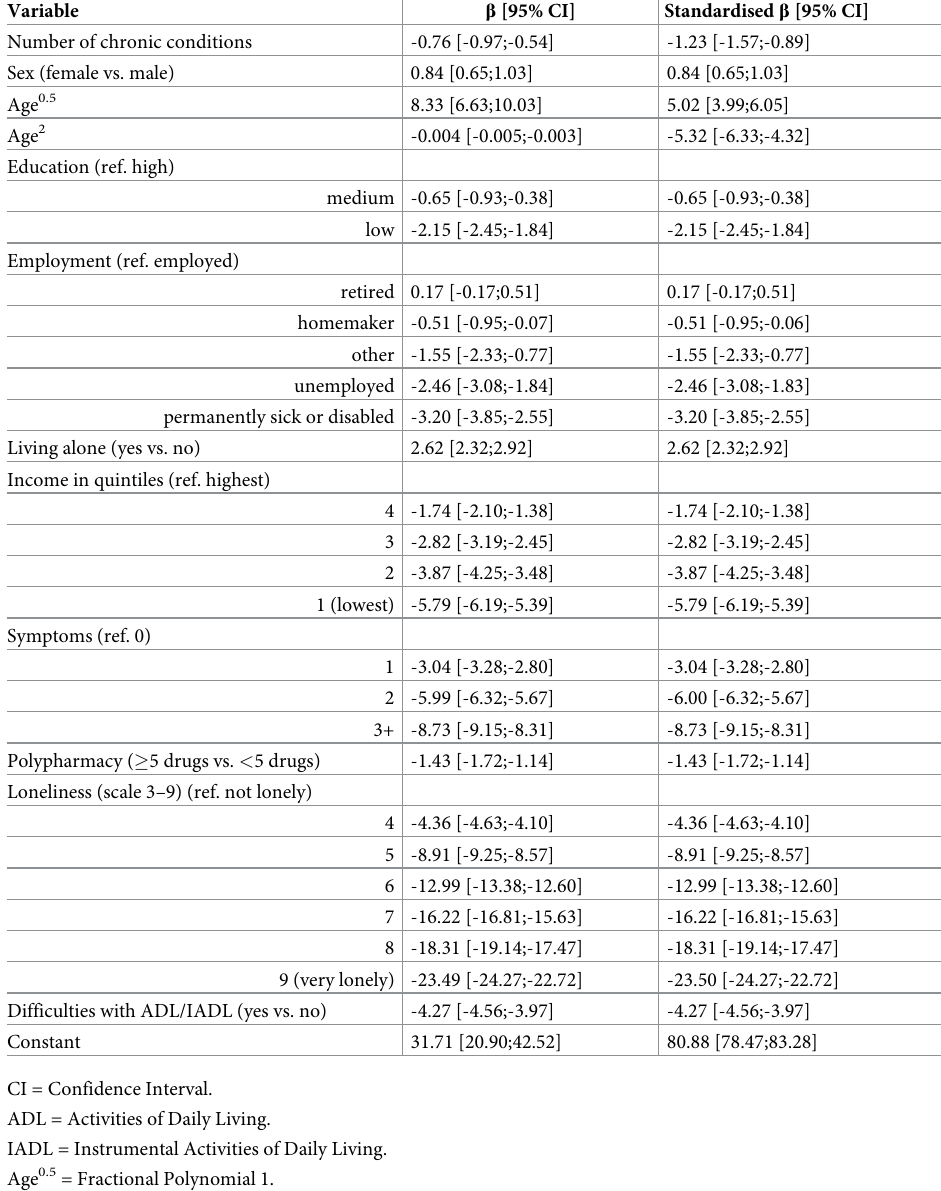
Table 5. Final multivariable model for quality of life.